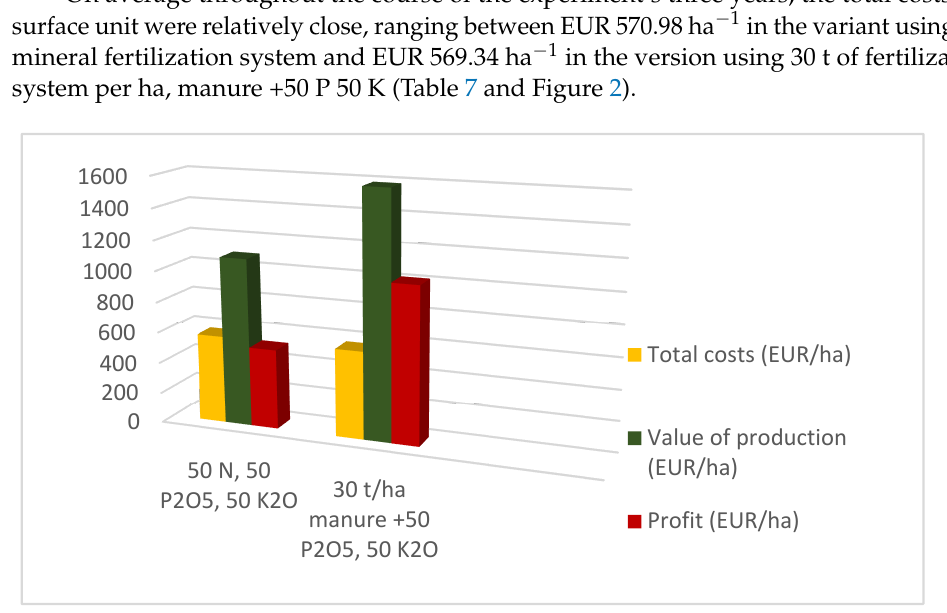
Figure 2. The influence of the agricultural fund on the efficiency of the sown meadow from Horezu – Vâlcea, Romania (average 2018 – 2020).